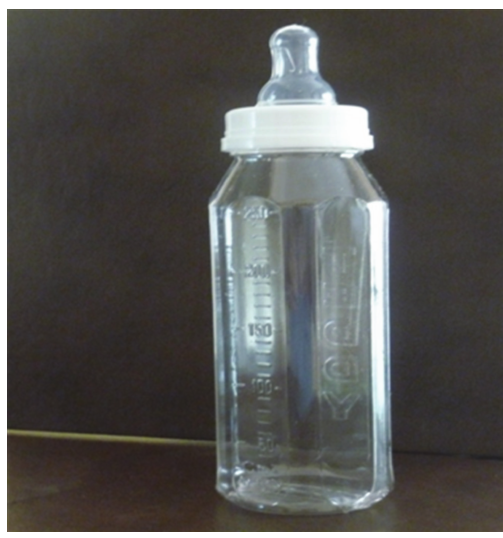
Figure 1: Standard